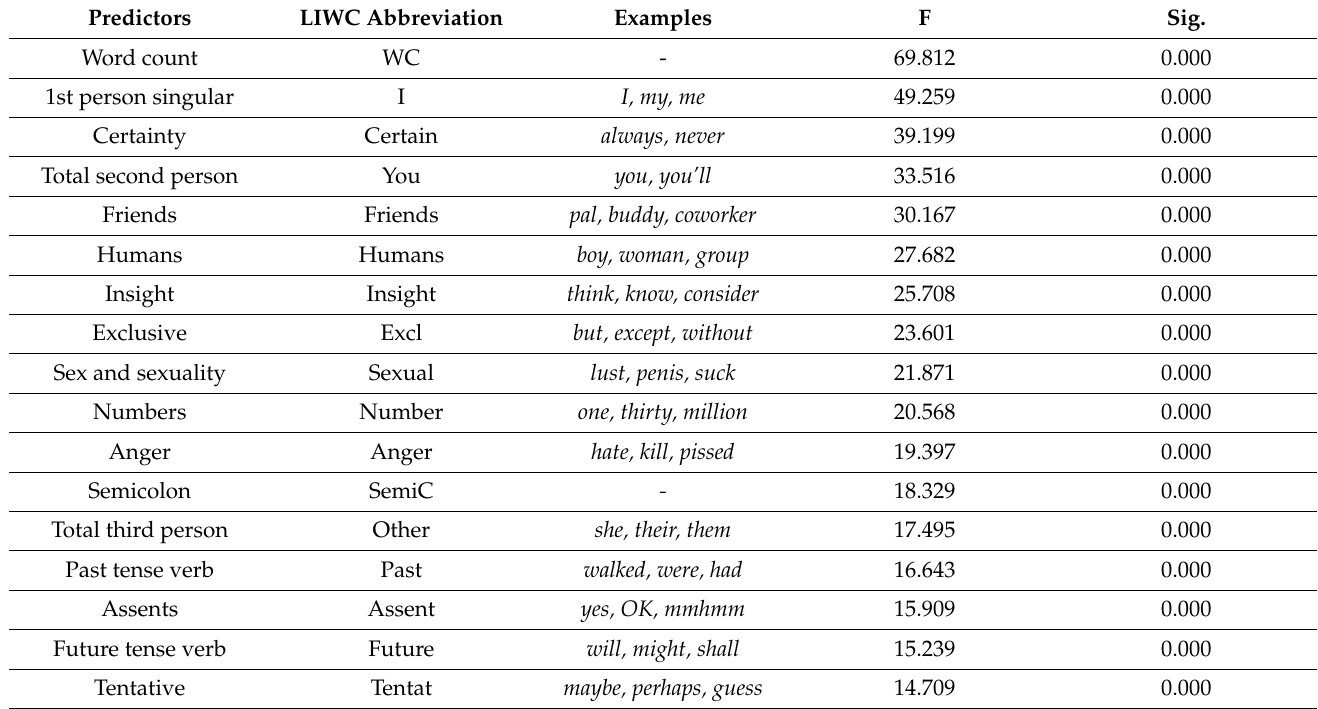
Table 1. F-ratios from